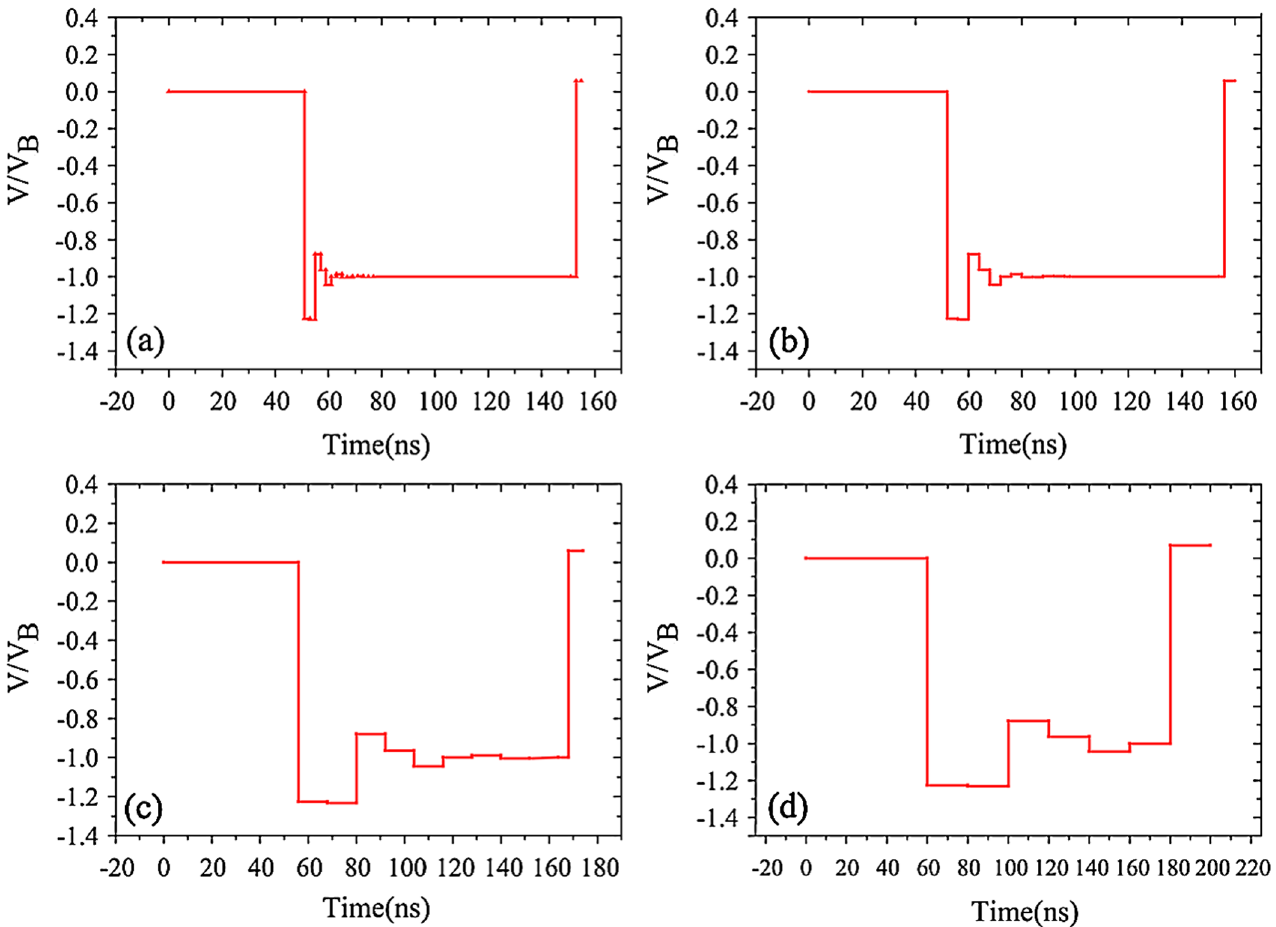
FIG. 4. (Color) The main pulse of the output voltage at different transmission time of the transition section, in all cases, (cid:1) 1 ¼ 50 ns , ¼ Z ¼ 6 (cid:6) , Z ¼ 10 (cid:6) , Z ¼ 12 (cid:6) , the transmission time of the transition section is varied: (a) (cid:1) Z 1 3 2 L (c) (cid:1) 2 ¼ 6 ns , (d) (cid:1) 2 ¼ 10 ns